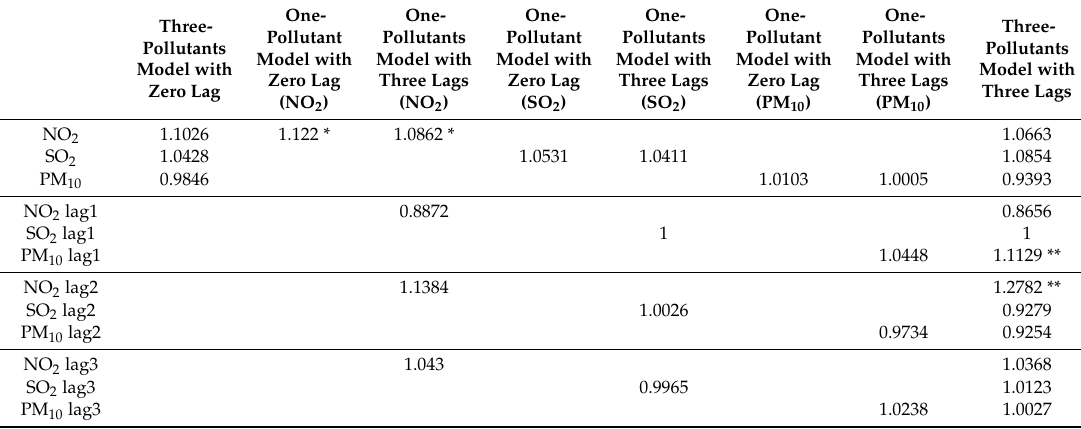
Table A4. Sensitivity analysis of relative risks (95% CI) of NPC incidence associated with a 10 µ g / m 3 increase in air pollutant concentration, adjusted only for meteorological variables with or without lagged